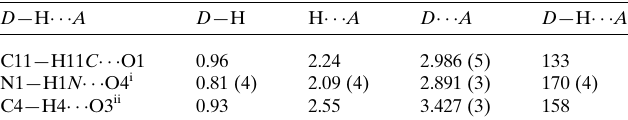
Table 1 Hydrogen-bond geometry (A˚ , (cid:3) ).